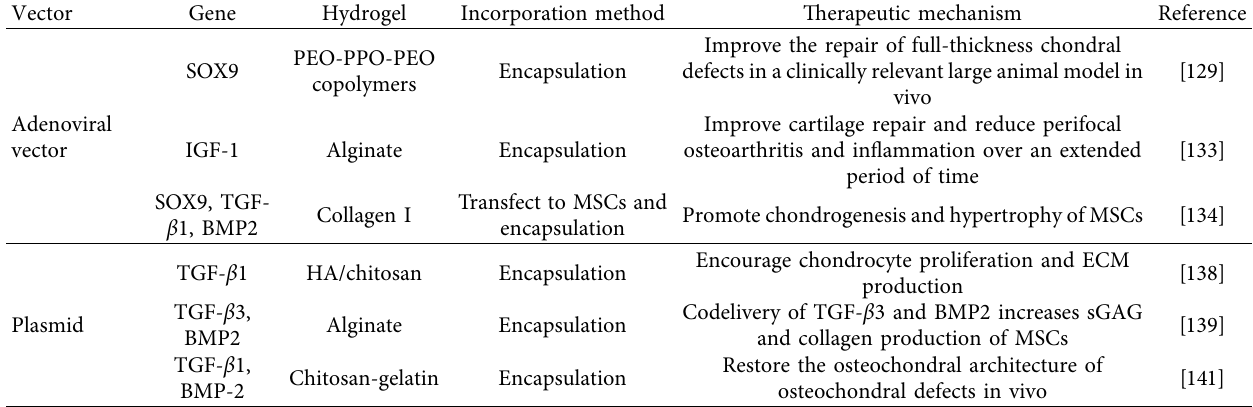
Table 2: Hydrogel used as cartilage regeneration gene delivery